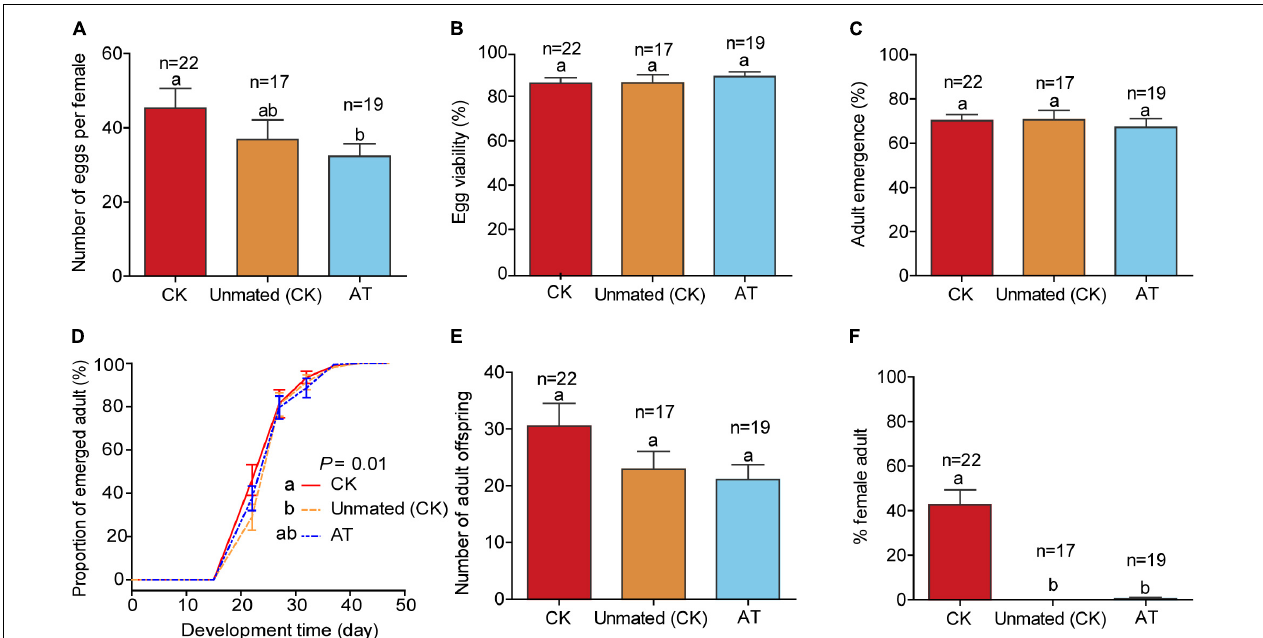
FIGURE 5 | Life history parameters of Hamiltonella -positive and Hamiltonella- free whiteflies on cotton plants. (A) Mean number of eggs per F1 female produced in 7 days; (B) Percentages of eggs that hatched; (C) Proportion of survival from the 1st instar nymph to adulthood; (D) Development time of progeny from egg to adulthood, expressed as the cumulative proportion of adult emergence; (E) The number of progenies that survived to adulthood; (F) Sex ratio of the adults. Unmated (CK): untreated virgin female adults; CK: untreated but mated females; AT: antibiotics-treated and mated females. In each replicate of Unmated CK, a female was allowed to oviposit for 7 days, and in each replicate of CK and AT, a female and a male were reared together to mate and oviposit for 7 days. The data are mean ± SEM, and the different letters indicate significant differences at P < 0.05.